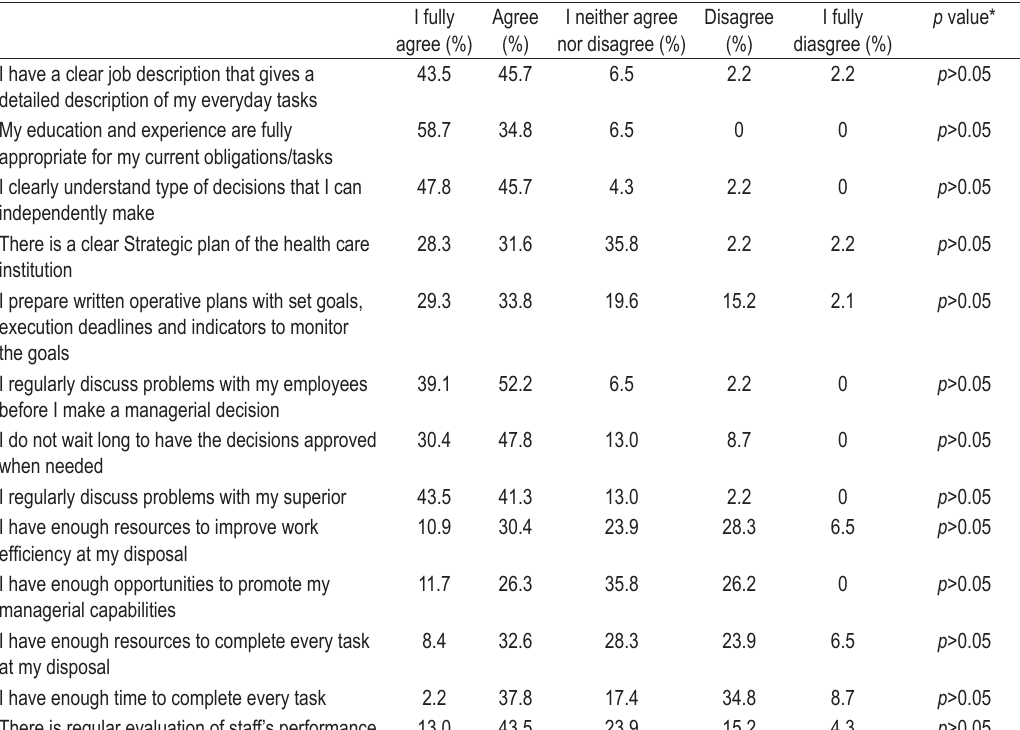
TABLE 3. Assessment of the personal managerial attitude and skills between the managers of different length of managerial